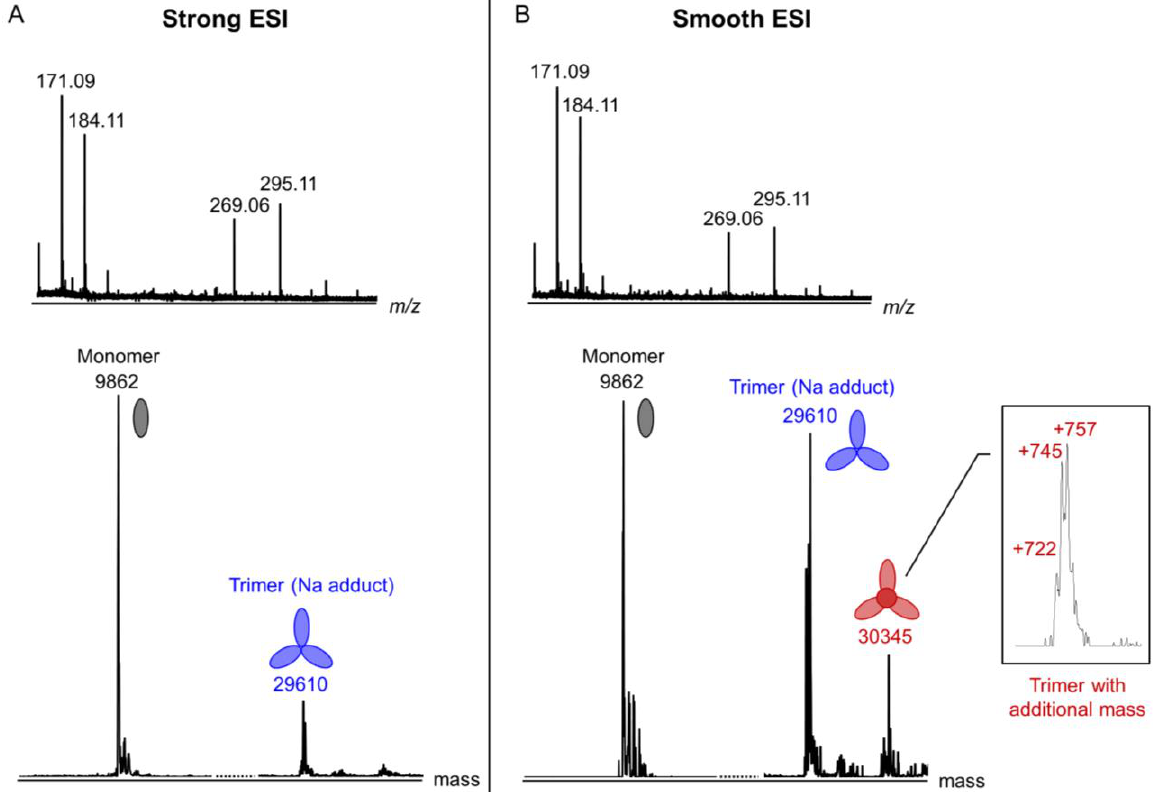
Figure 10. ESI-QTOF analysis of gp5 β -BC under different ionization conditions.